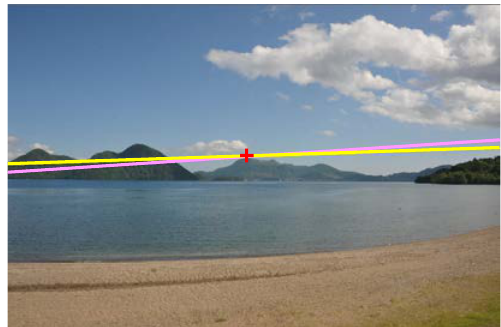
Figure 9. Evaluation of measurement result on ImageB